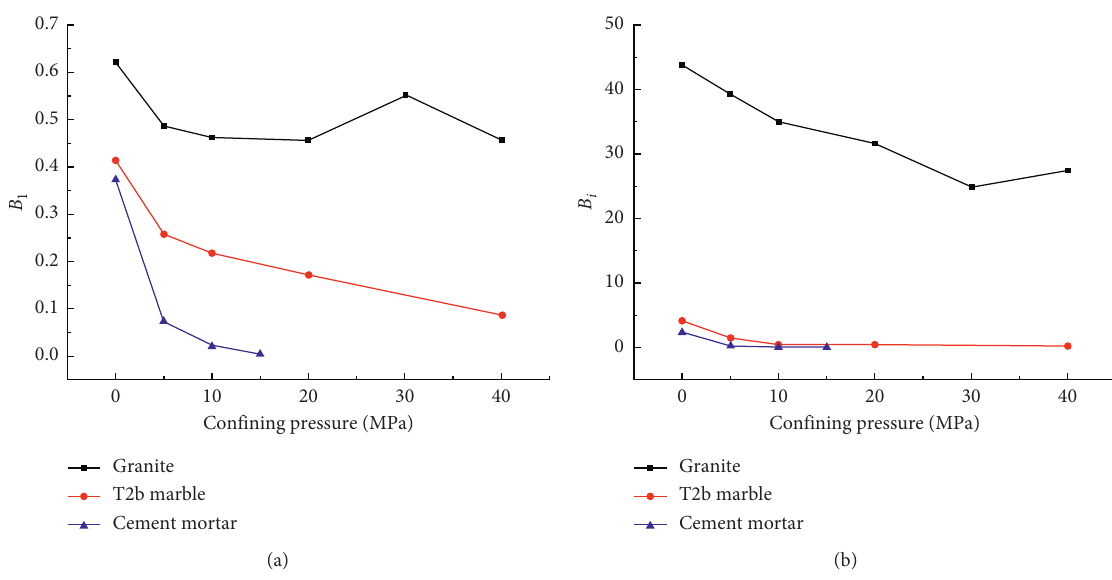
Figure 3: Brittleness order of materials under various confining pressure in different index systems: (a) B